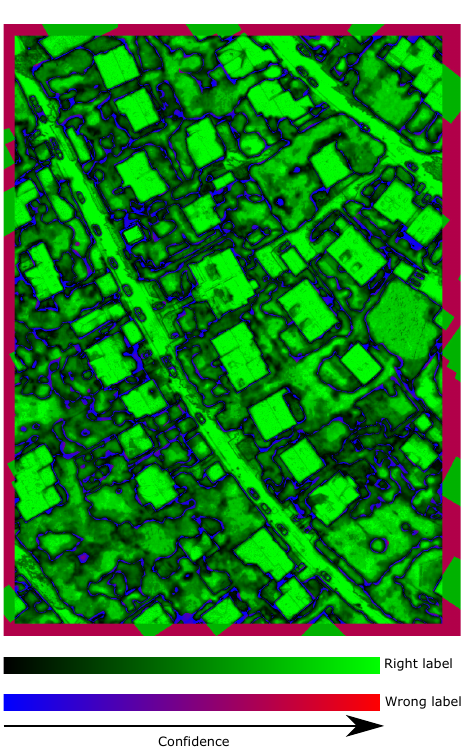
Figure 7. Visual results of our Bayesian U-Net on the ISPRS